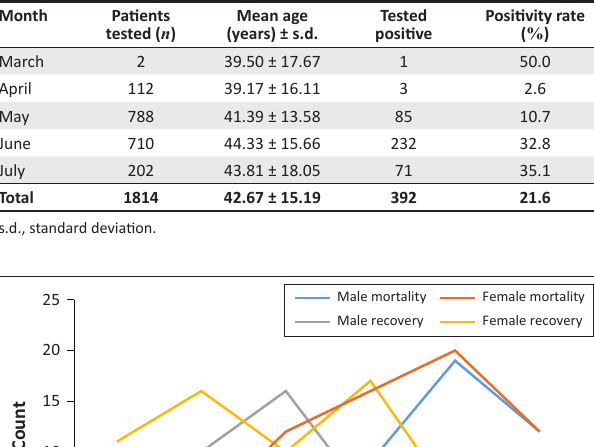
TABLE 2: Monthly distribution of patients tested for COVID-19 at Mthatha Regional Hospital ( n = 1814).